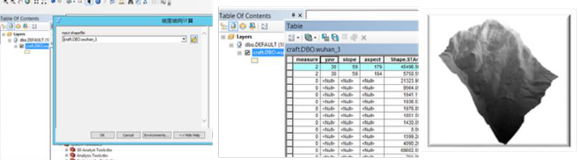
Figure 2. UAV near real time DEM generation and slope direction calculation toolbox